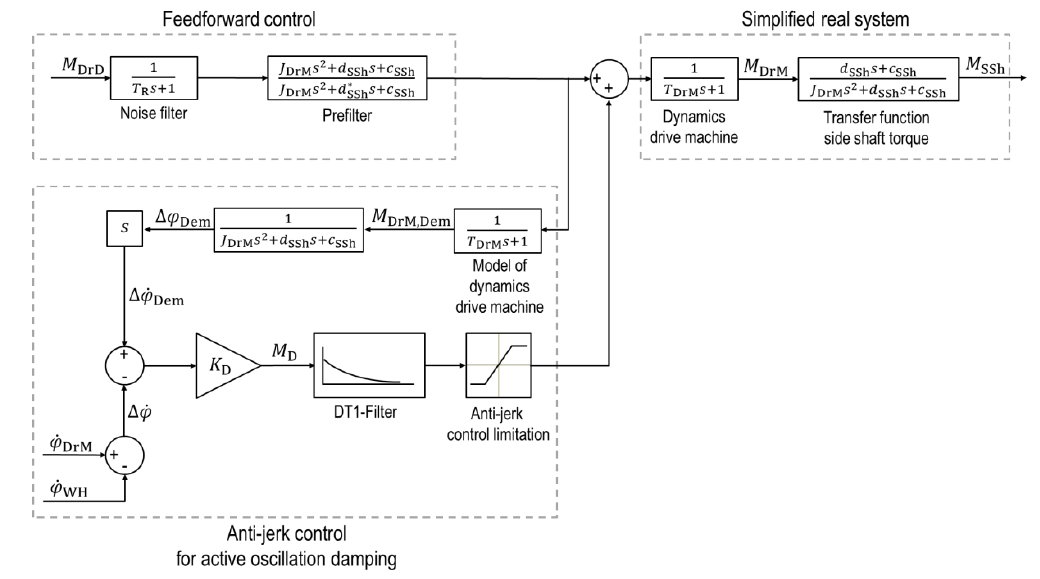
Figure 13. Drivability functions with prefilter, anti-jerk control and simplified real system.